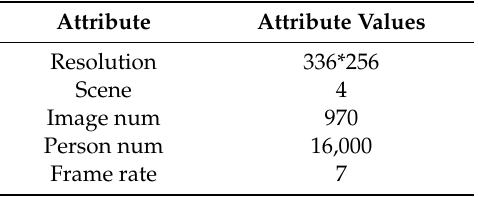
Figure 9. Representative images of our new crowd dataset. The samples in rows 1 to 4 indicate near the building, intersections, squares, and roads, respectively. Table 2. Details of the self-build datasets.